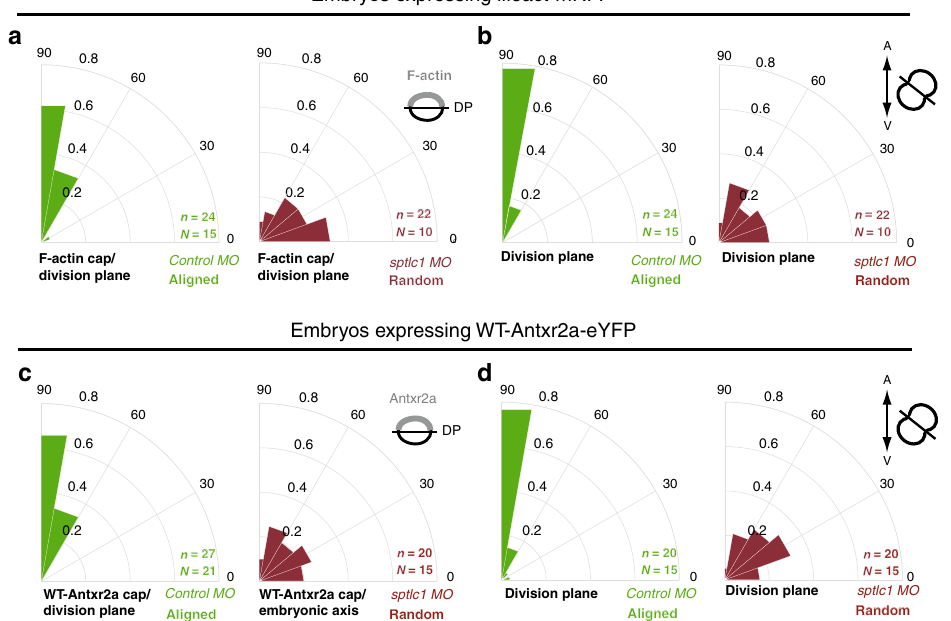
golipids results in a decrease in Antxr2a palmitoylation levels